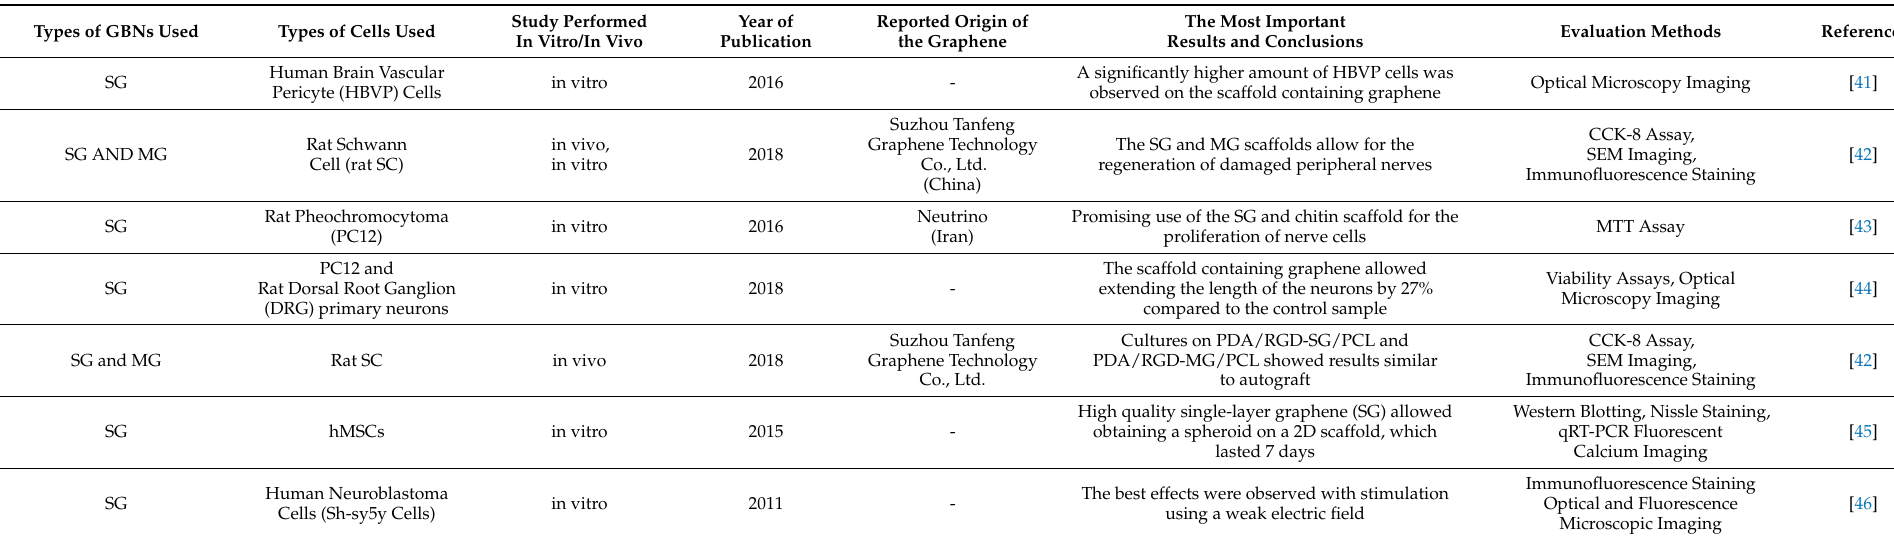
Table 4. List of relevant studies conducted with utilization of SG.